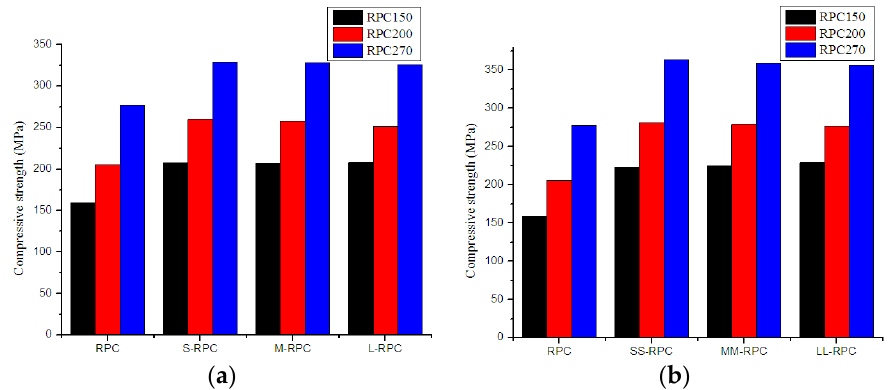
Figure 2. Effect of steel fiber length on the compressive strength of RPCs: ( a ) 0.5% fiber content and ( b ) 2.0% fiber content.